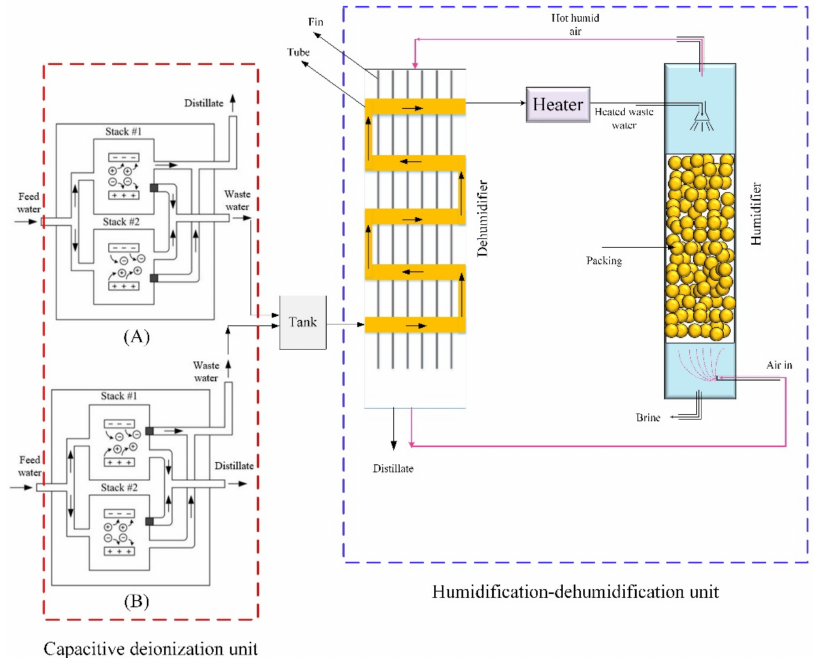
Figure 4. Schematic illustration of hybrid CDI–HDH system for brackish water desalination. Within CDI unit ( A ) Stack #1 is in adsorption mode and Stack #2 is in regeneration mode. ( B ) Stack #1 is in regeneration mode and Stack #2 is in adsorption